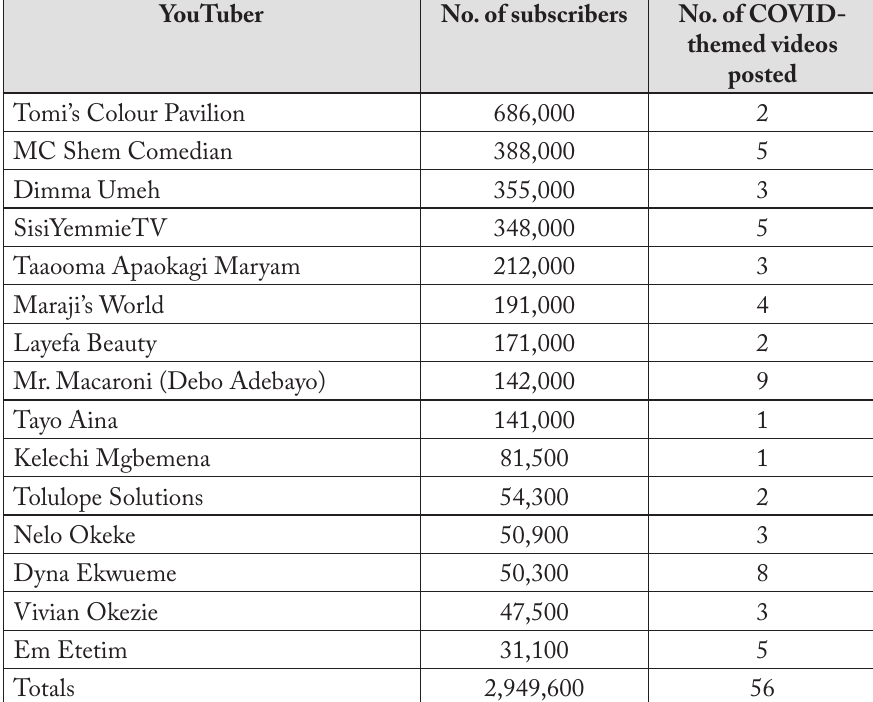
Table 1: YouTubers’ number of subscribers and number of COVID-themed videos